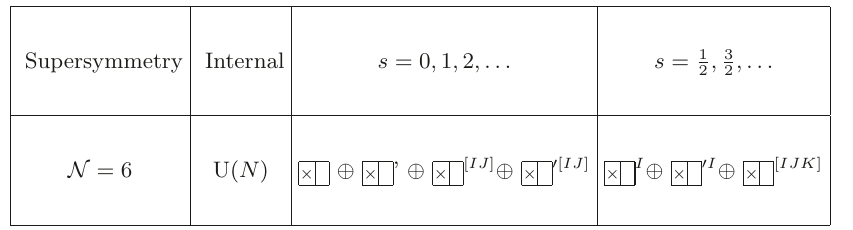
Table 3 . The spectra of the = 6 Vasiliev theories with the U( N ) internal symmetry. The indices N I, J, K label the fundamental representation of SO(6) R . The Young tableaux with the cross denote the adjoint representation of U( N